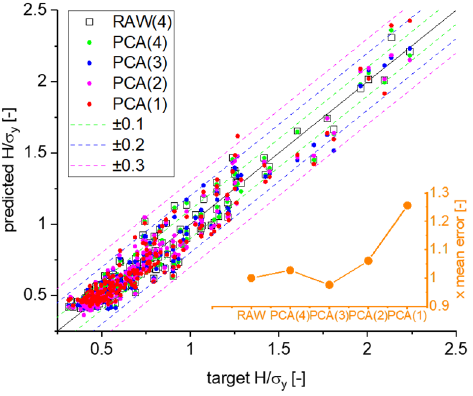
Figure 13. Principal component analysis of the dependence of H / σ y with respect to structural and macroscopic mechanical properties following Equation (26), combining data sets G 21 and G 33